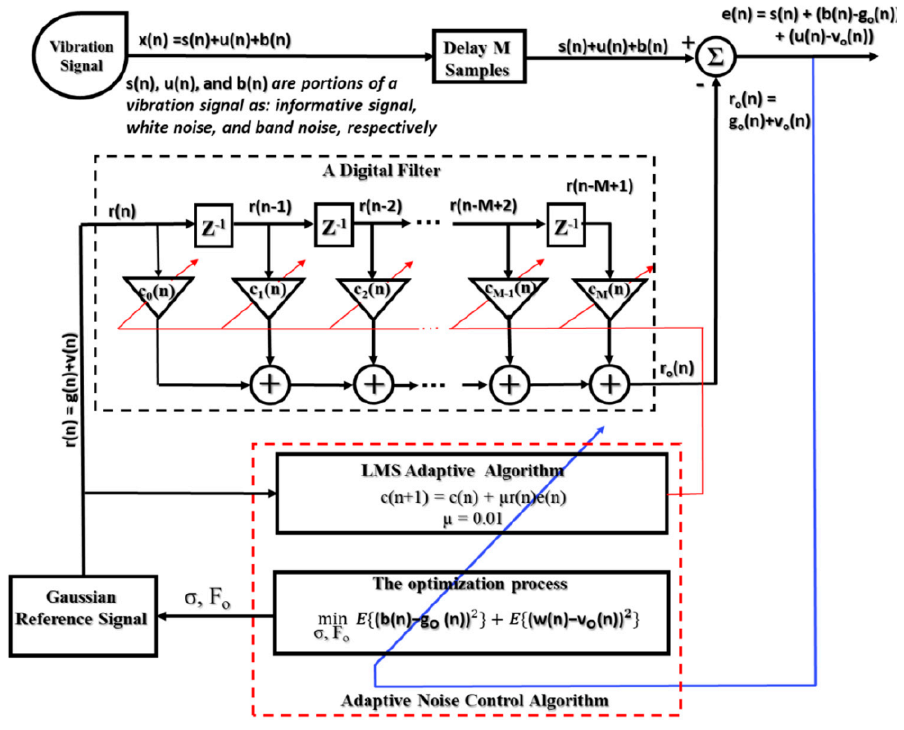
Figure 6. A functional block diagram of an adaptive noise control